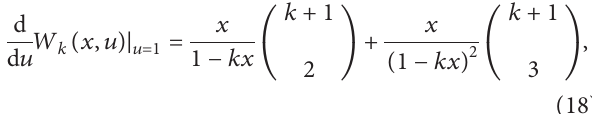
, q , . . . ) to be the generating 1 2